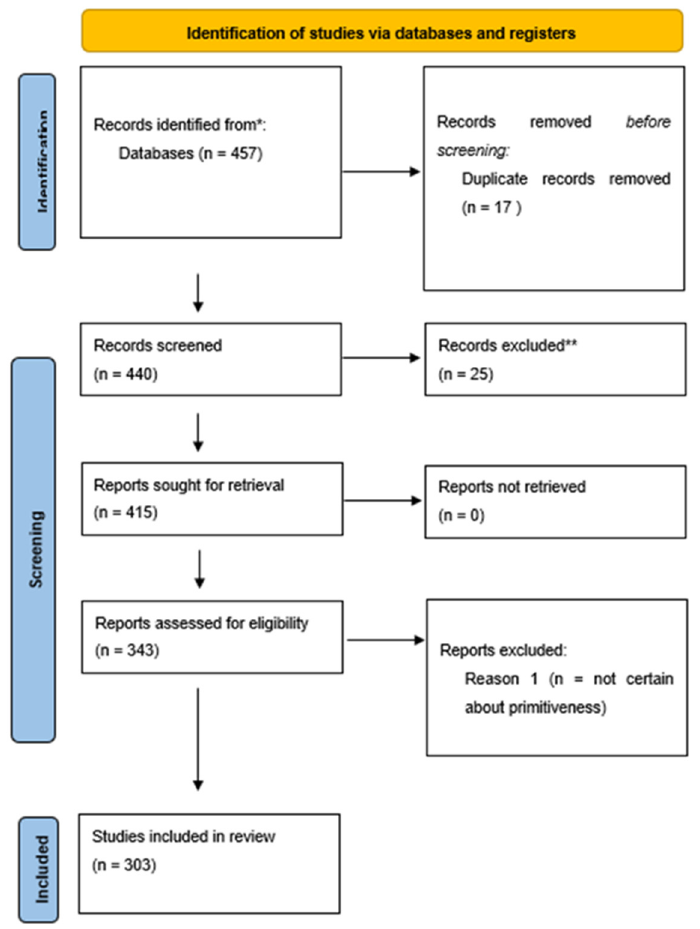
Figure 1. PRISMA 2020 flow-chart utilized in this review.